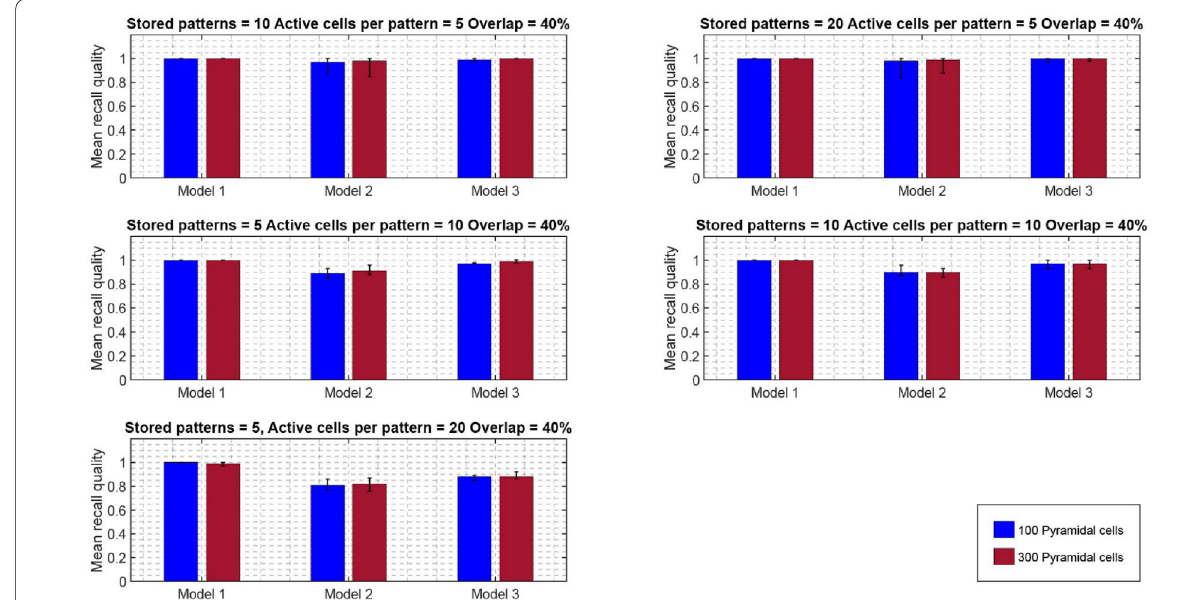
Fig. 9 Comparison of mean recall quality of ‘model 1’, ‘model 2’, and ‘model 3’ as a function of network size (100 PCs vs 300 PCs) for different numbers of stored patterns, active cells, and 40% pattern